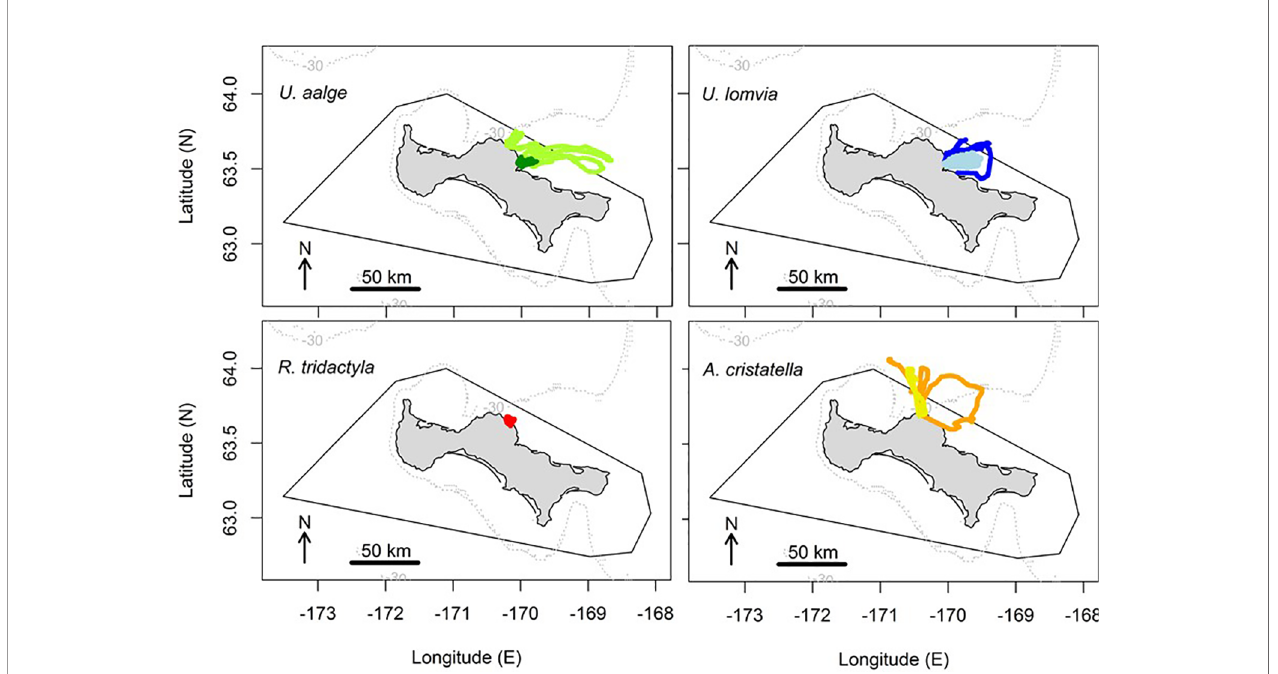
FIGURE 2 | At-sea distribution of the birds tracked from St. Lawrence Island (common murres U. aalge : n = 16 tracks, thick-billed murres U. lomvia : n = 20 tracks, black-legged kittiwake Rissa tridactyla : n = 5 tracks, and crested auklets Aethia cristatella : n = 6 tracks), relative to the contour of the Area To Be Avoided (black line). The tracks collected during the incubation versus chick-rearing stages are shown in darker versus lighter colors, respectively. The -30 m isobath is drawn in grey dotted